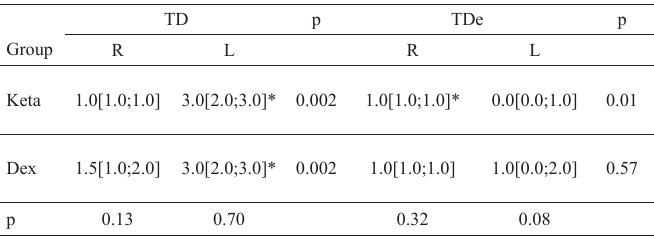
FIGURE 2 - Hematoxylin eosin-stained histological sections (40X) of rat left kidneys after ischemia-reperfusion injury. Anesthesia was induced with S (+)-ketamine, and maintained with S (+)-ketamine (keta group) or dexmedetomidine (dex group). A . Vascular dilation and congestion. B . Intense necrosis.